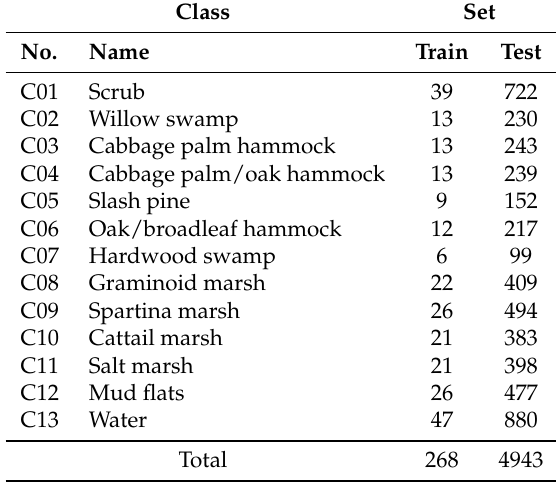
Table 4. Thirteen ground-truth classes in the AVIRIS Kennedy Space Center dataset and the number of training and test pixels used in the